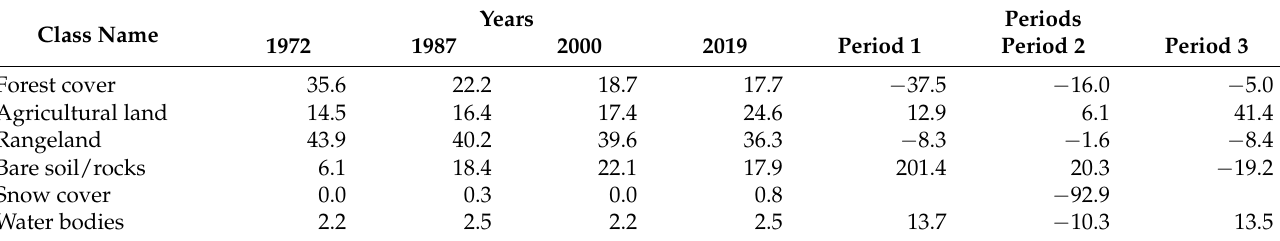
Table 8. Land use land cover within 3 km of local